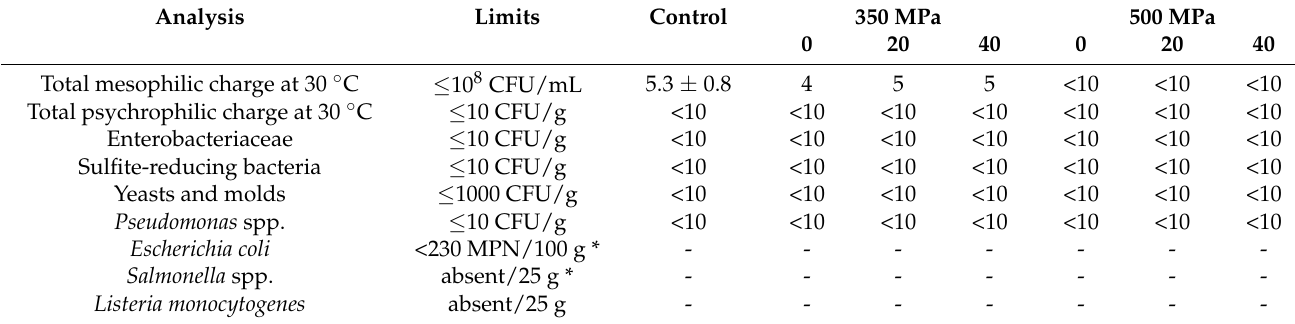
Table 9. Microbiological analysis carried out on fresh and HPP